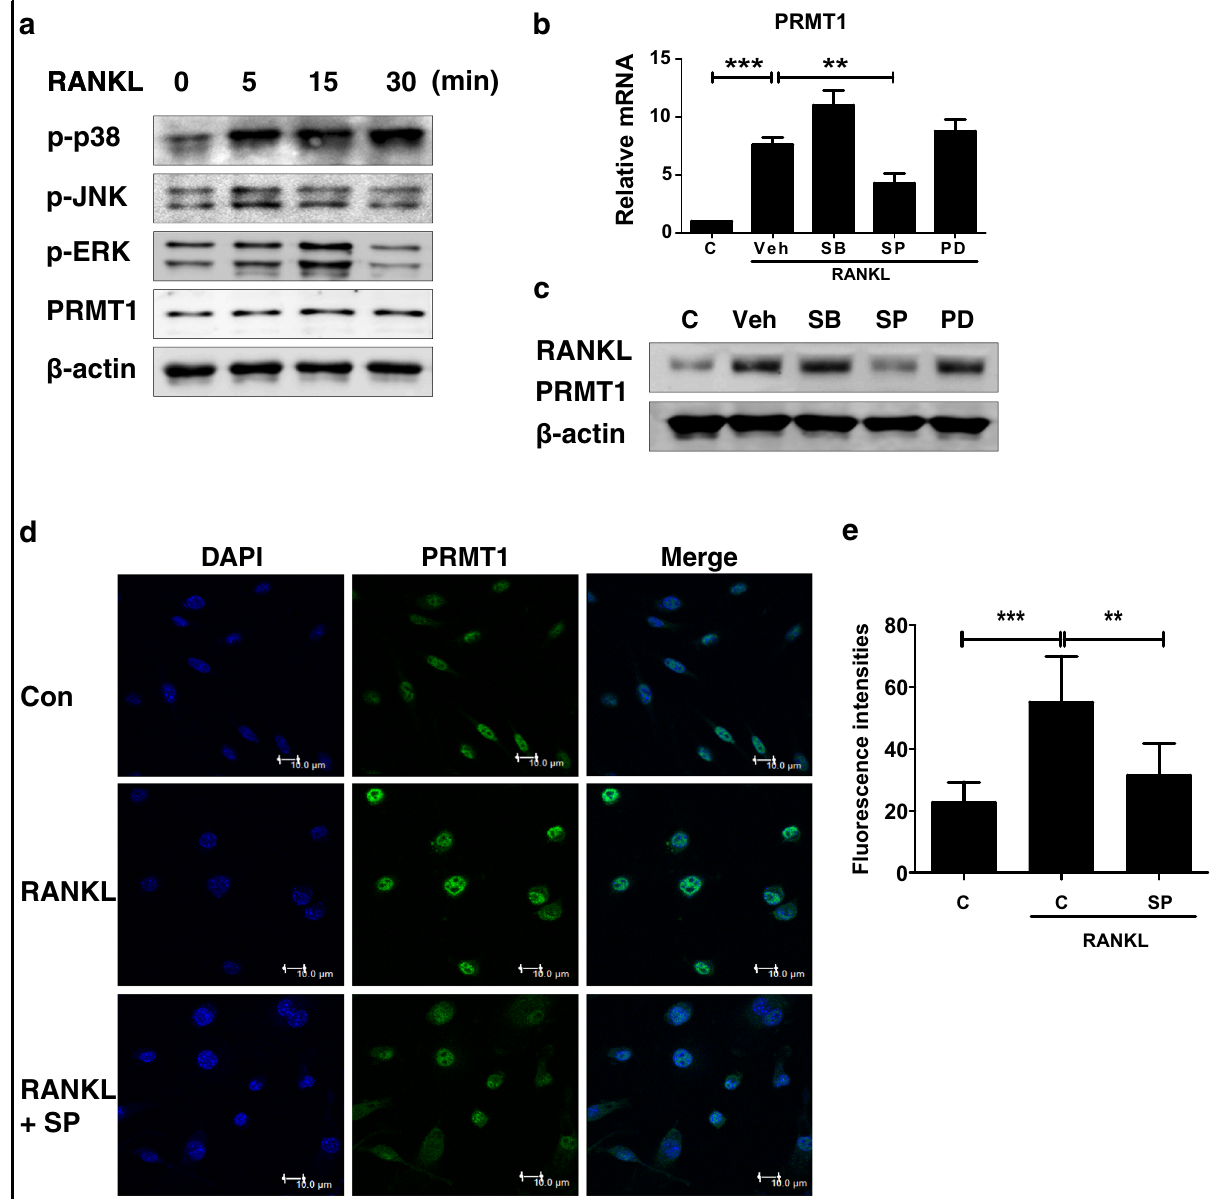
Fig. 4 RANKL treatment increases PRMT1 expression via JNK-dependent signaling in osteoclast differentiation. a BMDMs were stimulated by RANKL (100 ng/ml) at the indicated time points and were subjected to western blotting with the indicated antibodies. b-d The BMDMs were pre- treated with DMSO (Veh), SB 203580 (SB, 10 μ M), SP 600125 (SP, 10 μ M) or PD 98059 (PD, 10 μ M) in the presence of M-CSF (30 ng/ml). After 30 min, the cells were stimulated with RANKL (100 ng/ml) for 24 h. b PRMT1 protein expression was examined via western blotting and c its mRNA level was measured with a real-time PCR analysis normalized to the β -actin level. The results are expressed as the mean ± SD. ** p < 0.01, *** p < 0.001. d The cells were labeled with anti-PRMT1 and fl uorescein isothiocyanate (FITC)-conjugated secondary antibody, and the nuclei were stained with DAPI and observed under a confocal microscope. Representative images are from at least three independent experiments. Scale bar: 10 μ m. e Fluorescence intensities were obtained from the mean value of the selected regions in the image using Leica Application Suite Advanced Fluorescence (LAS AF) software (Leica Microsystems). The results are expressed as the mean ± SD. ** p < 0.01, *** p <